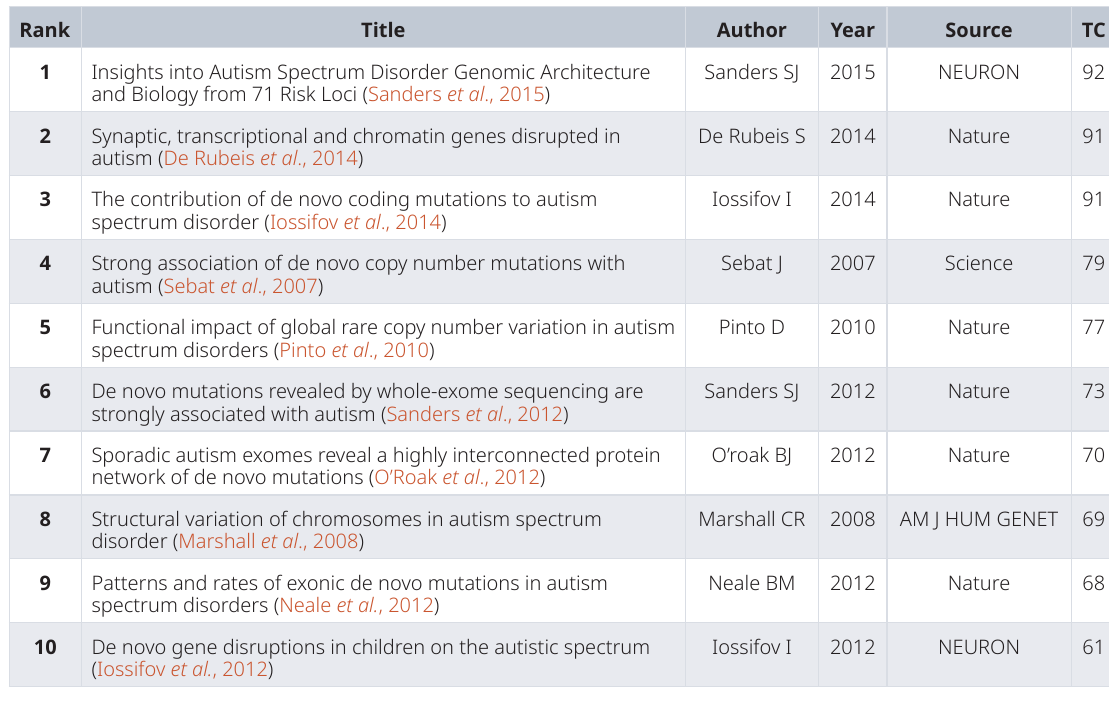
Table 8. top ten cited